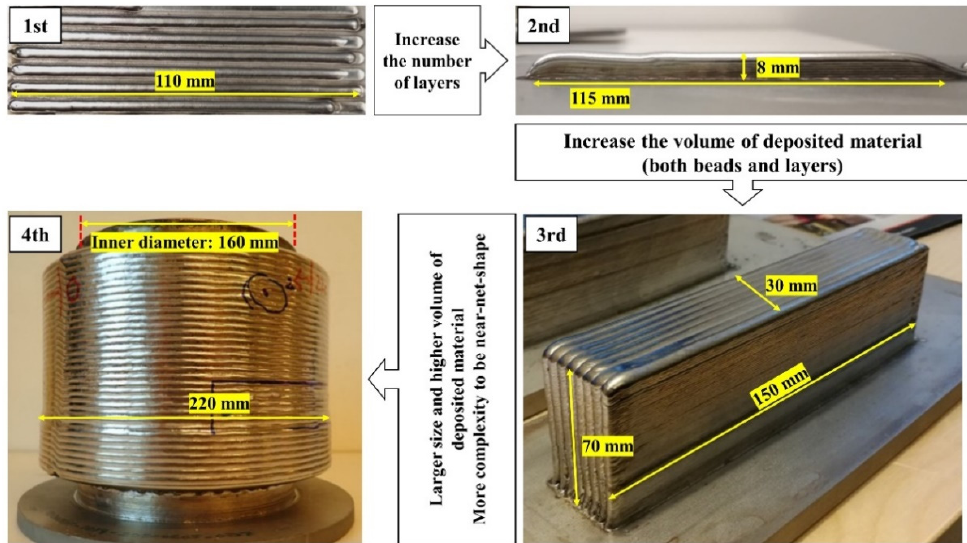
Figure 3. Four-stage methodology in LMDw of DSS cylinder. First: single-bead pass (1 bead, 3.5 g); second: single-bead wall (10 beads, 35 g); third: block (2.5 kg); and fourth: cylinder (>20 kg). The deposition volume and complexity were increased stepwise to reach the final component.